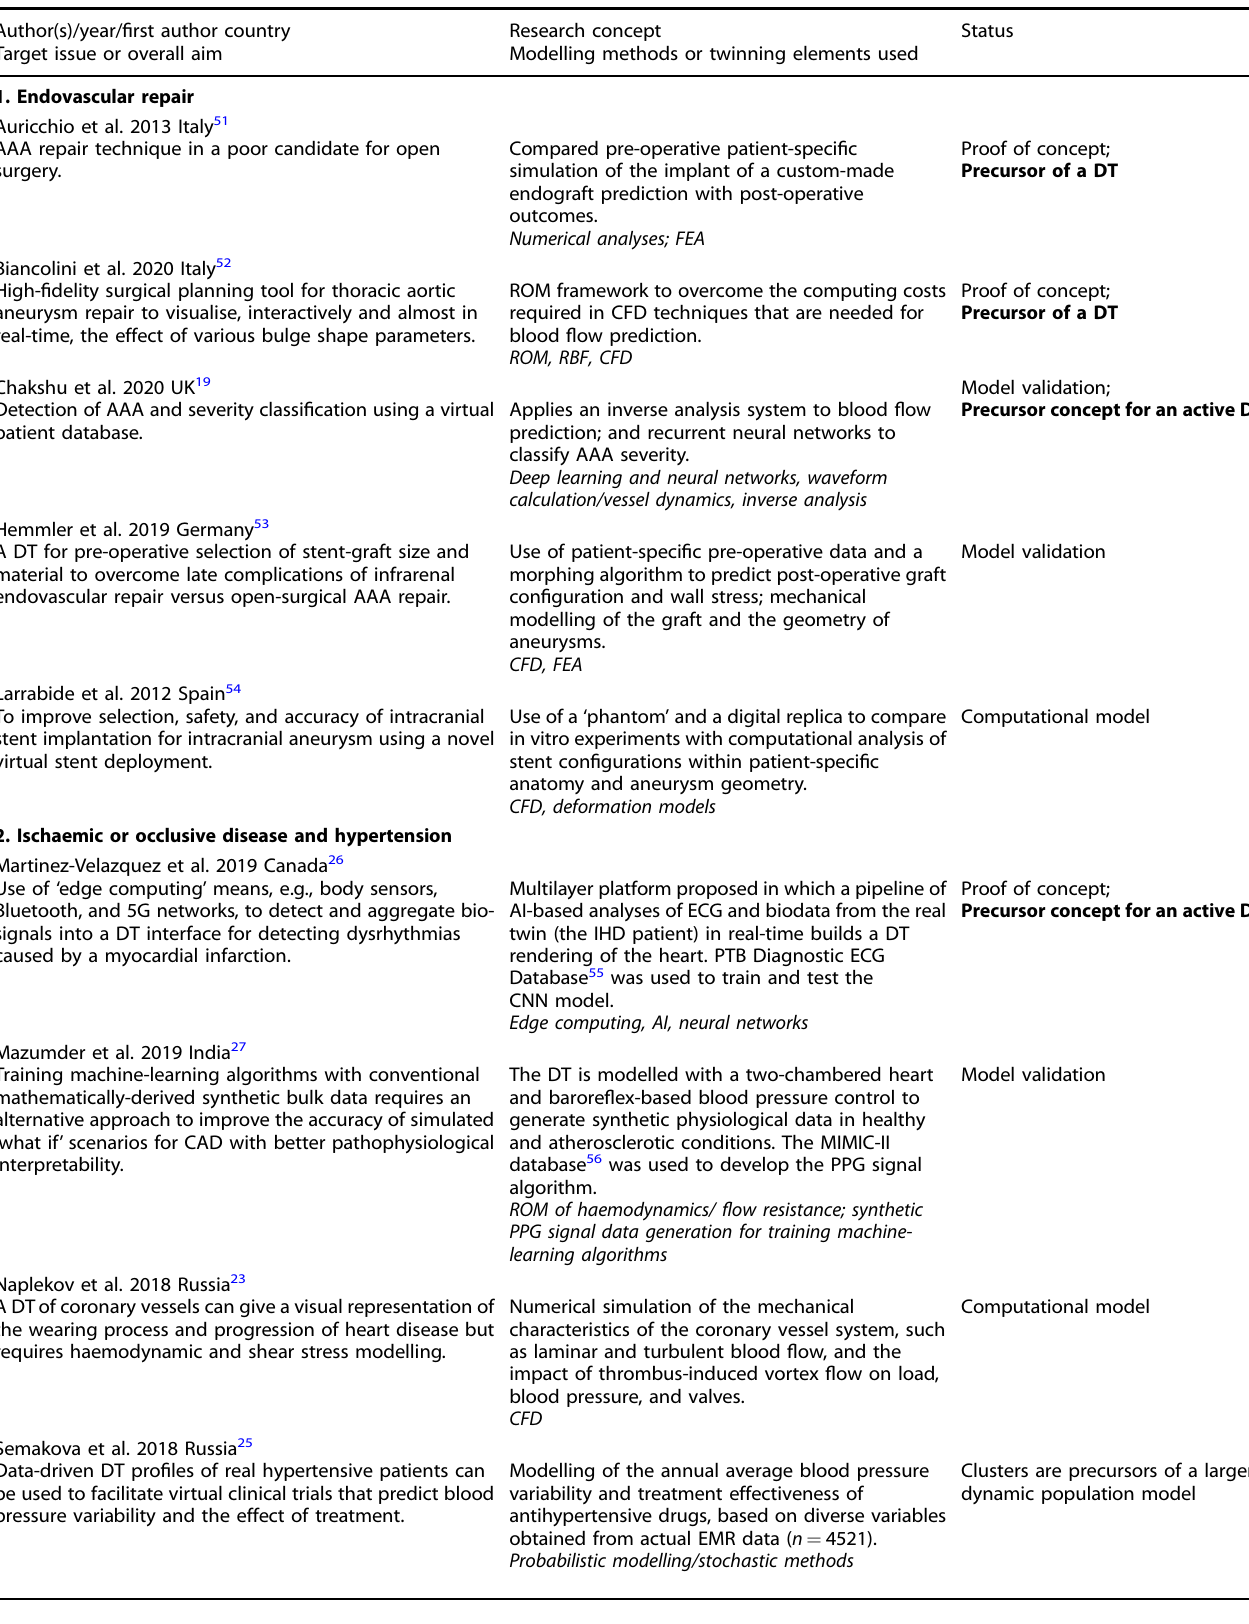
Table 1. Digital twin-related applications in cardiovascular